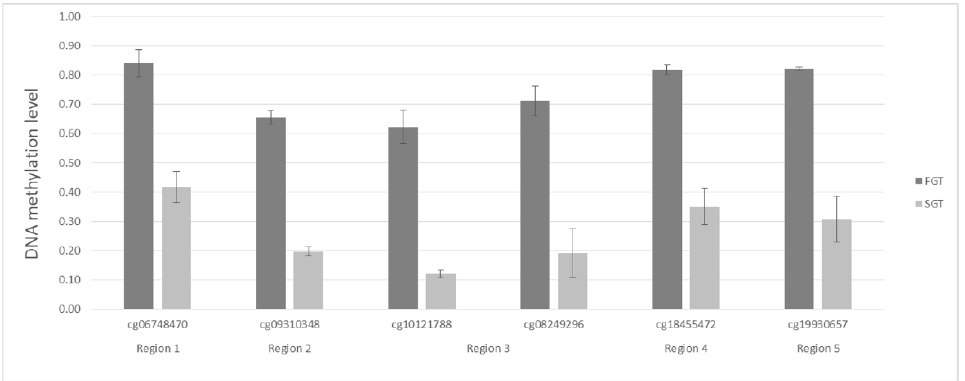
Figure 3. Mean methylation levels between fast-growing (dark gray) and slow-growing (light gray) tumors for the six CG tags selected based on the results of the Illumina Infinium Human Methylation EPIC BeadChip Array.